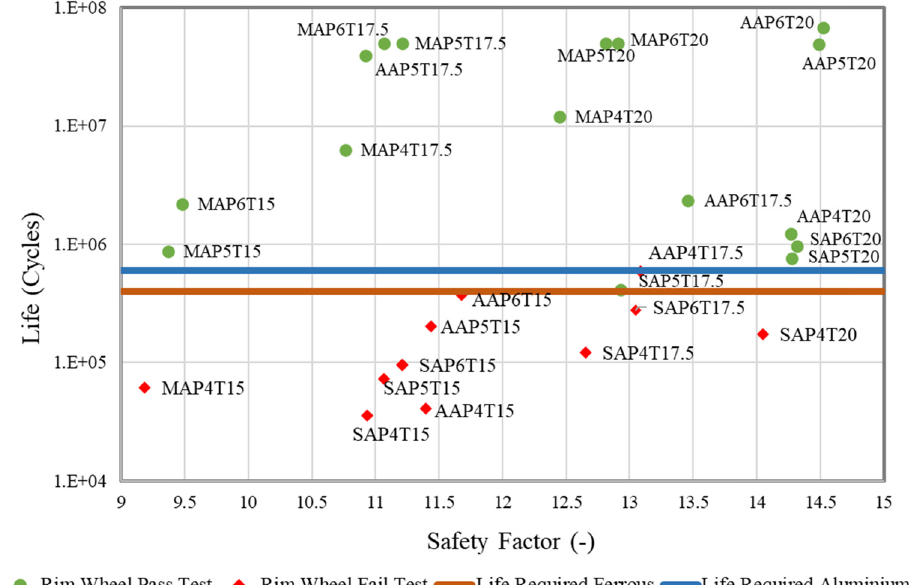
Figure 9: Rim wheel life due to the SAE standardization